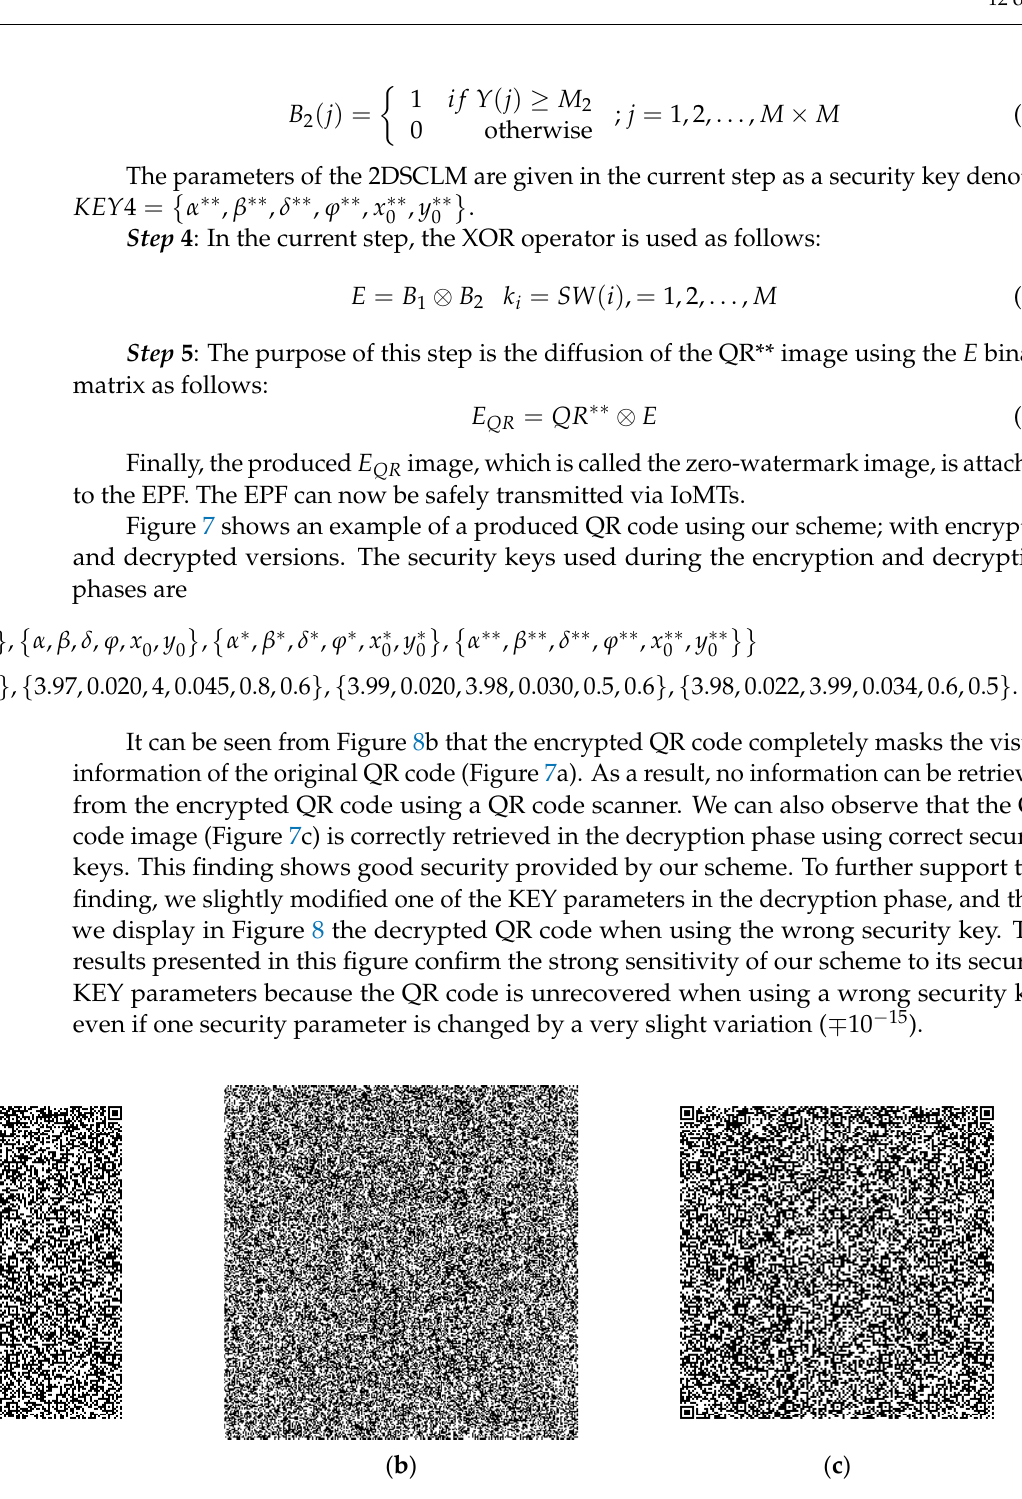
Figure 7. ( a ) Original QR code, ( b ) its encrypted form, and ( c ) its decrypted form using correct KEY .